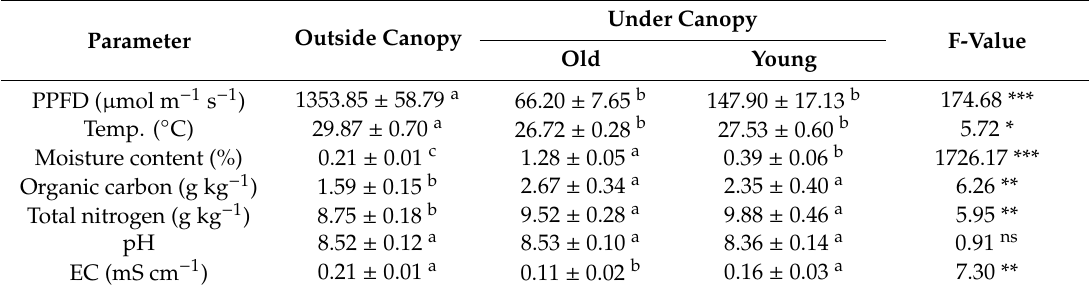
Table 1. Photosynthetic photon flux density (PPFD) and soil parameters under the canopy of C. polygonoides and outside the canopy. Values are average ± standard error ( n = 15). Means followed by di ff erent letters within each row are significantly di ff erent after Duncan’s post-hoc test.